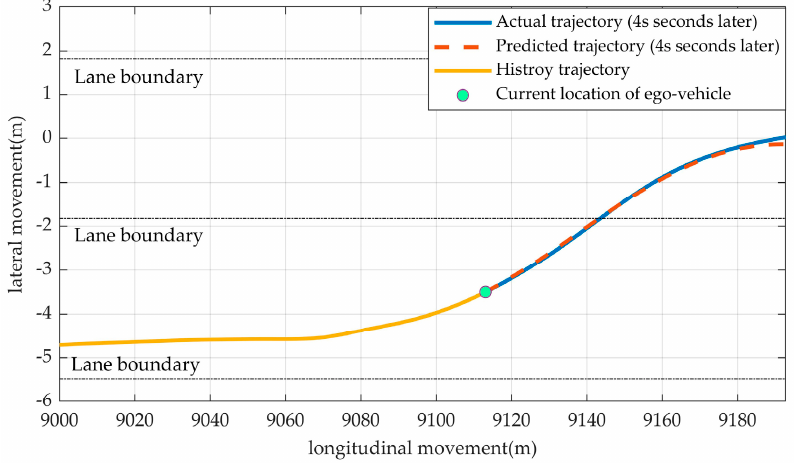
Figure 6. A predicted target trajectory when the driver was changing lanes (from subject 7). Since the predicted trajectory and the actual trajectory were almost aligned, our model could give a prediction of the driver’s target